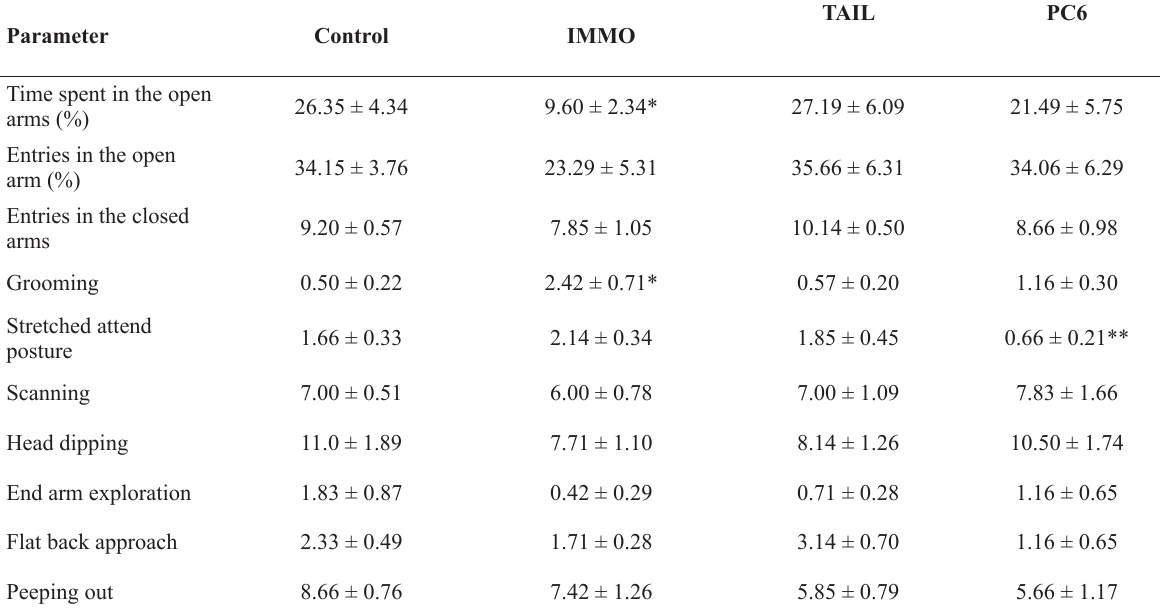
Behavior in the elevated plus-maze test of control rats and of rats submitted to immobilization (IMMO) and IMMO plus electroacupuncture at the tail or at PC6.